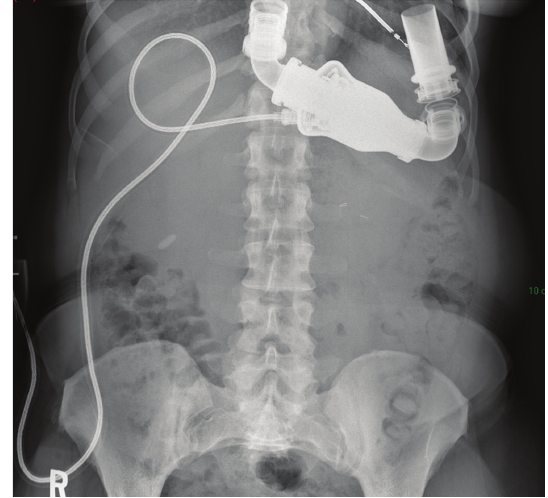
Figure 3: Confirmation of no retained sponge with series of ab- dominal plain